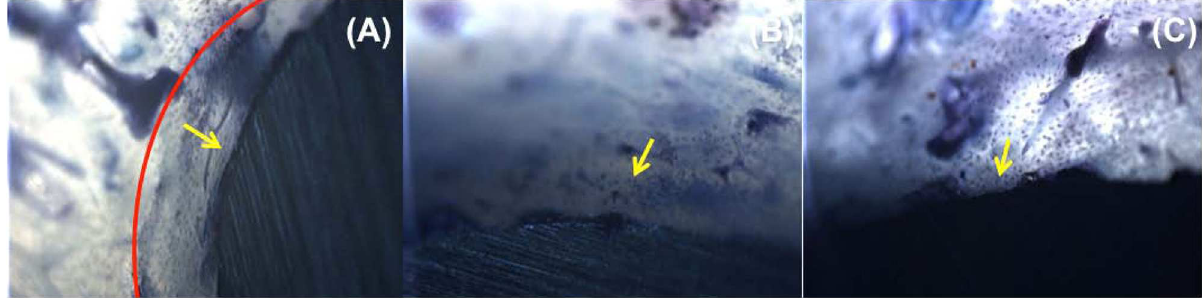
Fig 13. Photomicrography of slides stained by toluidine blue. Histological samplesof (A) SLAffinity, (B) commercial, and (C) sand- blasted groupsat 3 months post-surgery. Red semicircleindicatesnew bone formation at interface betweenhost bone tissue and screw implant. Osteocyte formation is indicatedby yellow arrow (originalmagnification